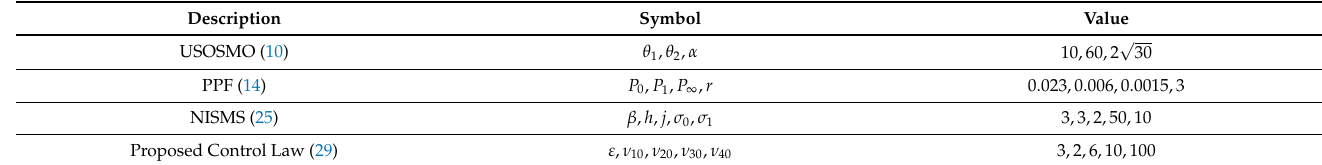
Table 4. Control parameter selection for the proposed scheme.